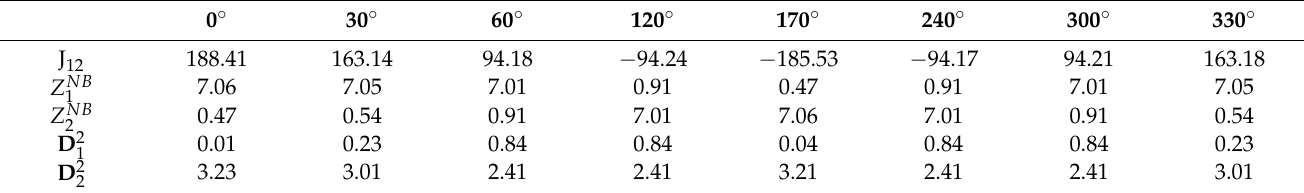
Table A1. Parameters of the BChl dimer model: Z-coordinates of the BChl 1 and BChl 2 Q y transition moments in the site representation are –5 Å and 5 Å. These moments lie on a line connecting the NB and ND nitrogen atoms of the pyrrole ring of BChl. J 12 is coupling energy between BChl molecules calculated in dipole–dipole approximation. Z NB Z NB are the Z-coordinates of BChl 1 and BChl 2 Q y transition moments in the exciton representation. D 2 2 squared exciton transition moments. The parameters are calculated for different angles between transition moments in the site